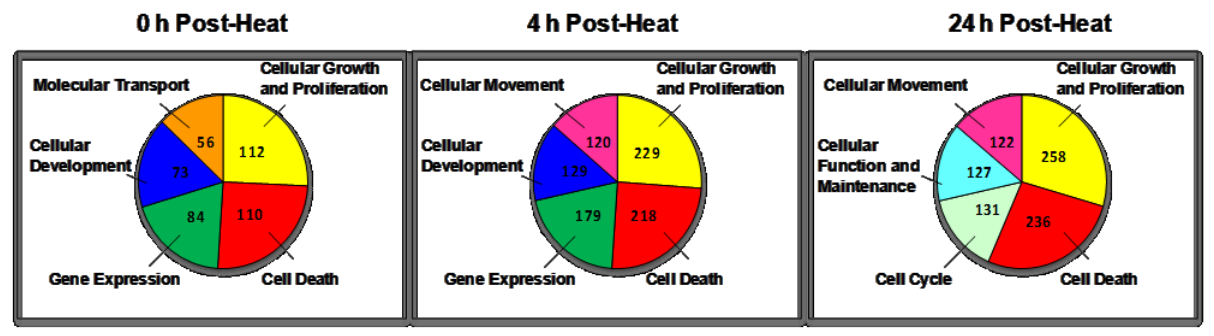
Figure 4. Pie chart of the top five cellular and molecular functions at each time point. Each sector of the pie chart represents the total number of genes expressed for each cellular function. Genes were filtered for an absolute value log p ≤ 0.05.